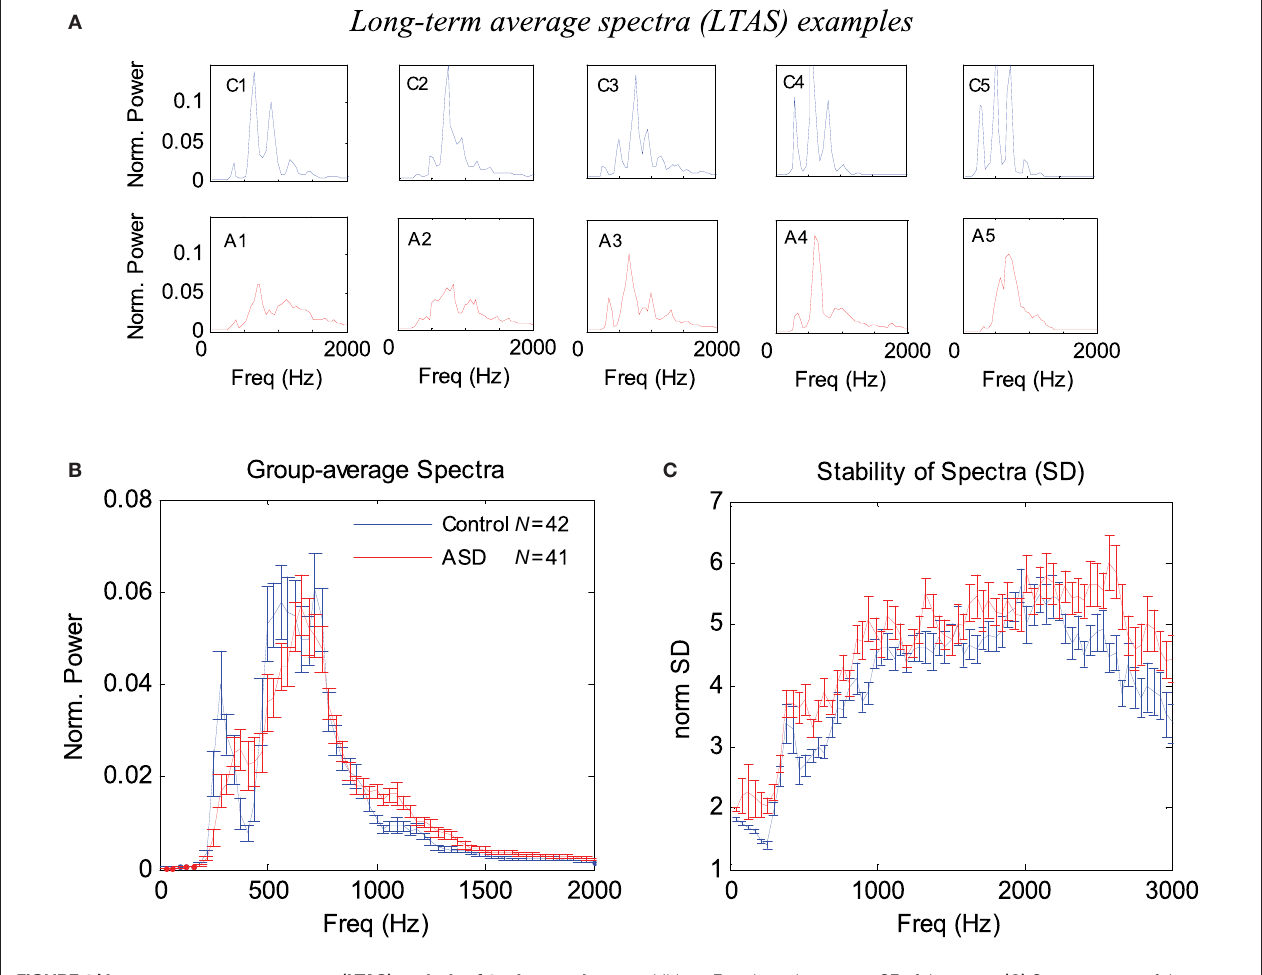
Figure 1 | Long-term average spectrum (LTAS) analysis of 1-min speech (naming) of ASD and control children. (A) Examples of normalized LTAS of five controls (C1–C5) and five ASD children (A1–A5). Note that the controls have higher and more numerous spectral peaks, whereas the ASD curves are shallower. (B) Group average of normalized LTAS for 42 controls and 41 ASD